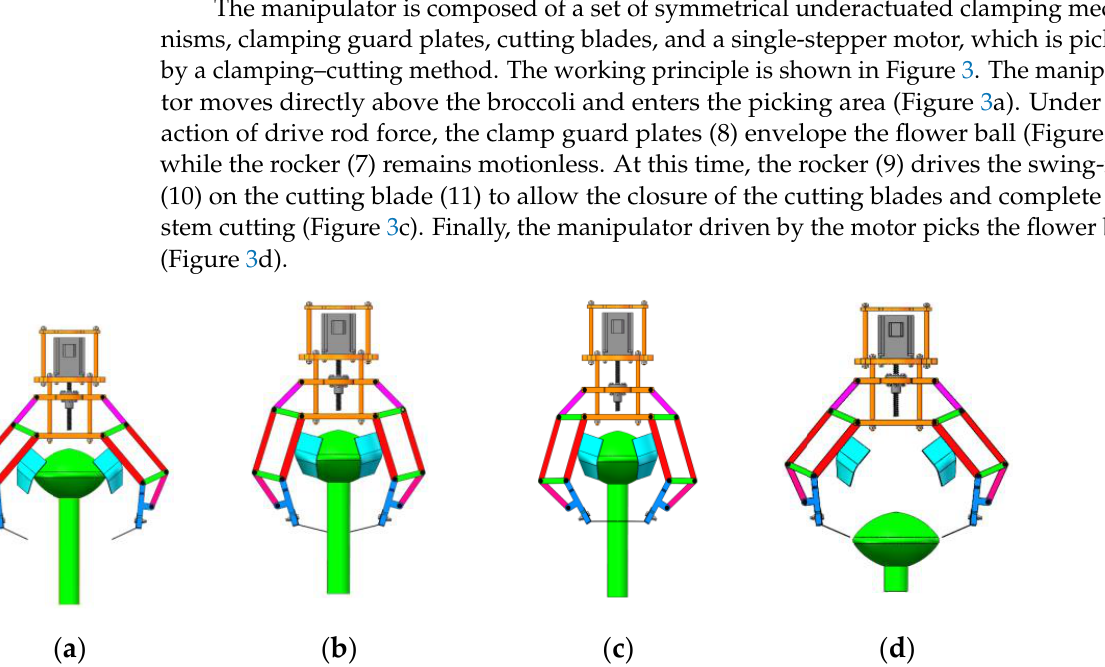
Figure 4. Clamping workspace of the manipulator. An LDW-1 universal material test machine and cutting tool (304 stainless steel; length, 80 mm; width, 50 mm; thickness, 2 mm; tool point angle, 8°) was used. Thirty flowers with no surface damage were selected to determine the flower surface pressure and stem-cutting force, as shown in Figure 5.